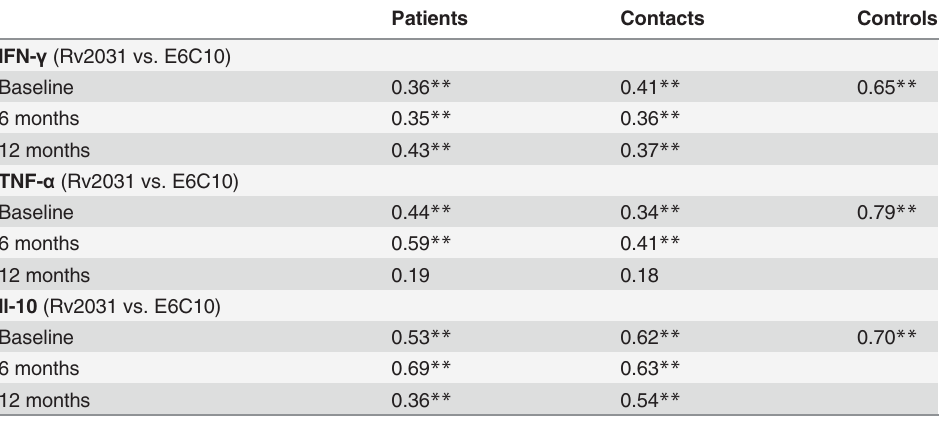
Table 2. Correlation between E6C10 and Rv2031 specific IFN- γ , TNF- α and IL-10. Patients